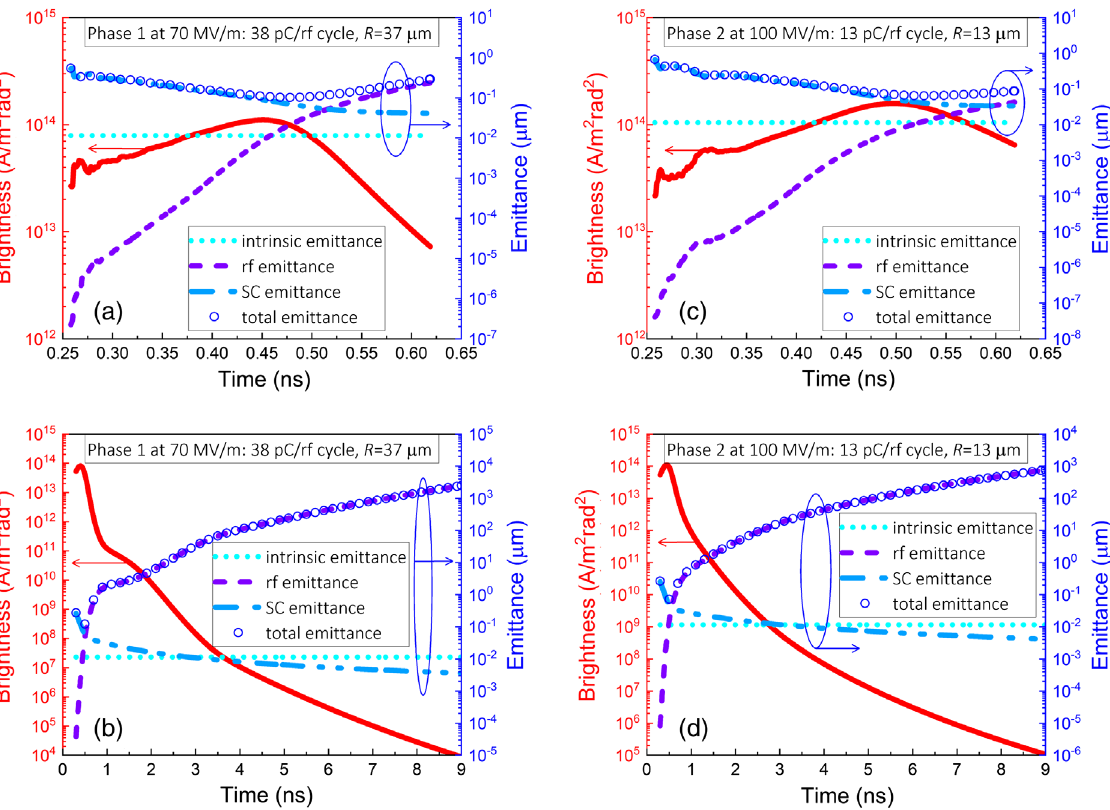
FIG. 10. Brightness dynamics inside the gun for (a) Phase 1 and (c) Phase 2 and along the entire beamline from the cathode to YAG3 for (b) Phase 1 and (d) Phase 2. For reference, the gun exit corresponds to the time stamp of 0.45 ns for all the